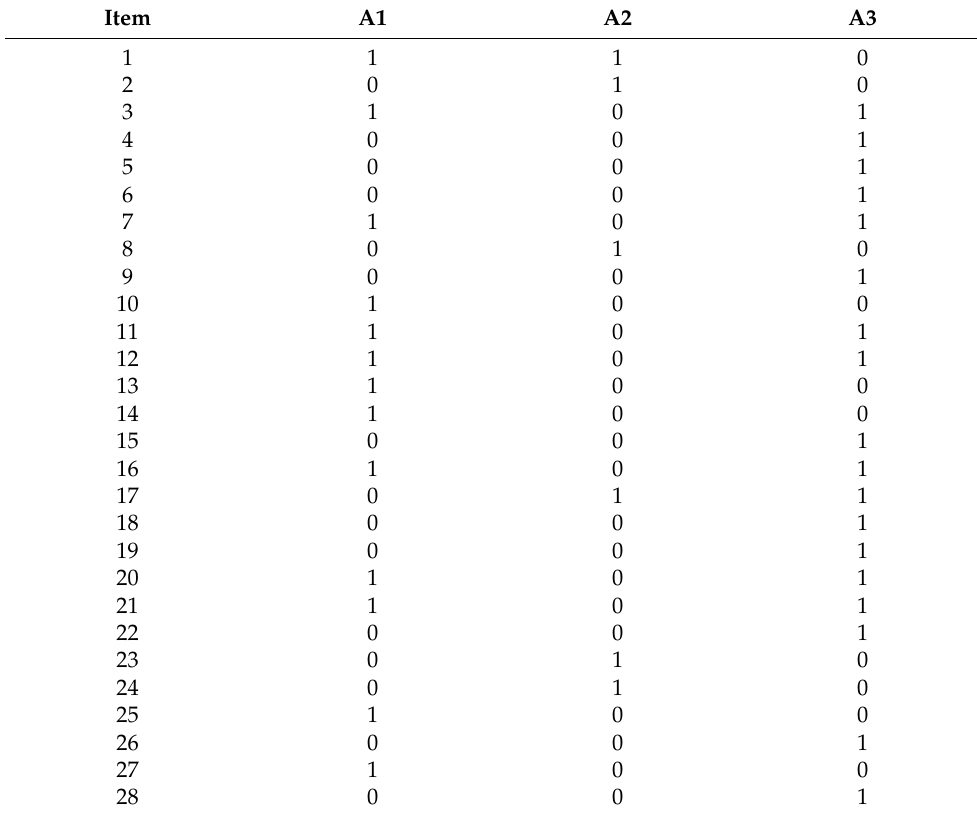
Table 1. Q-Matrix of the ECPE